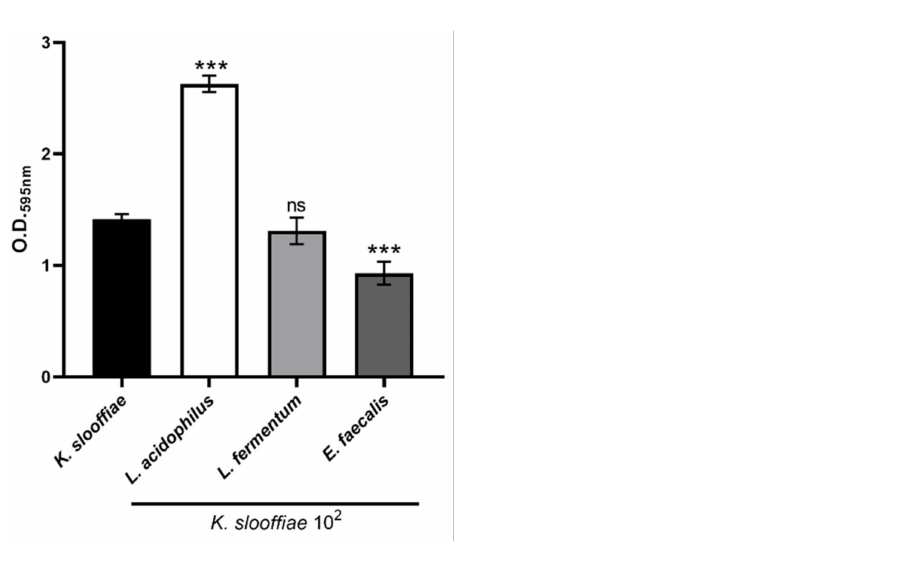
Figure 6. Biofilm assessment of K. slooffiae . K. slooffiae was grown in De Man, Rogosa, Sharpe broth (MRS) broth for 72 h without shaking at 37 ◦ C and 5% CO 2 . Following fixation, biofilms were stained with 0.4% crystal violet, washed, and O.D. readings were taken at 595 nm. Bacterial supernatants were co-incubated with K. slooffiae biofilms to assess any alterations in the presence of Lactobacillus acidophilus , Lactobacillus fermentum , and Enterococcus faecalis . Data shown is three combined experiments of seven total experiments. ( n = 16 to 64). One-way ANOVA with a Tukey post-test was performed to determine significance. Error bars represent the standard deviation and *** represents p < 0.0001 in comparison to K. slooffiae